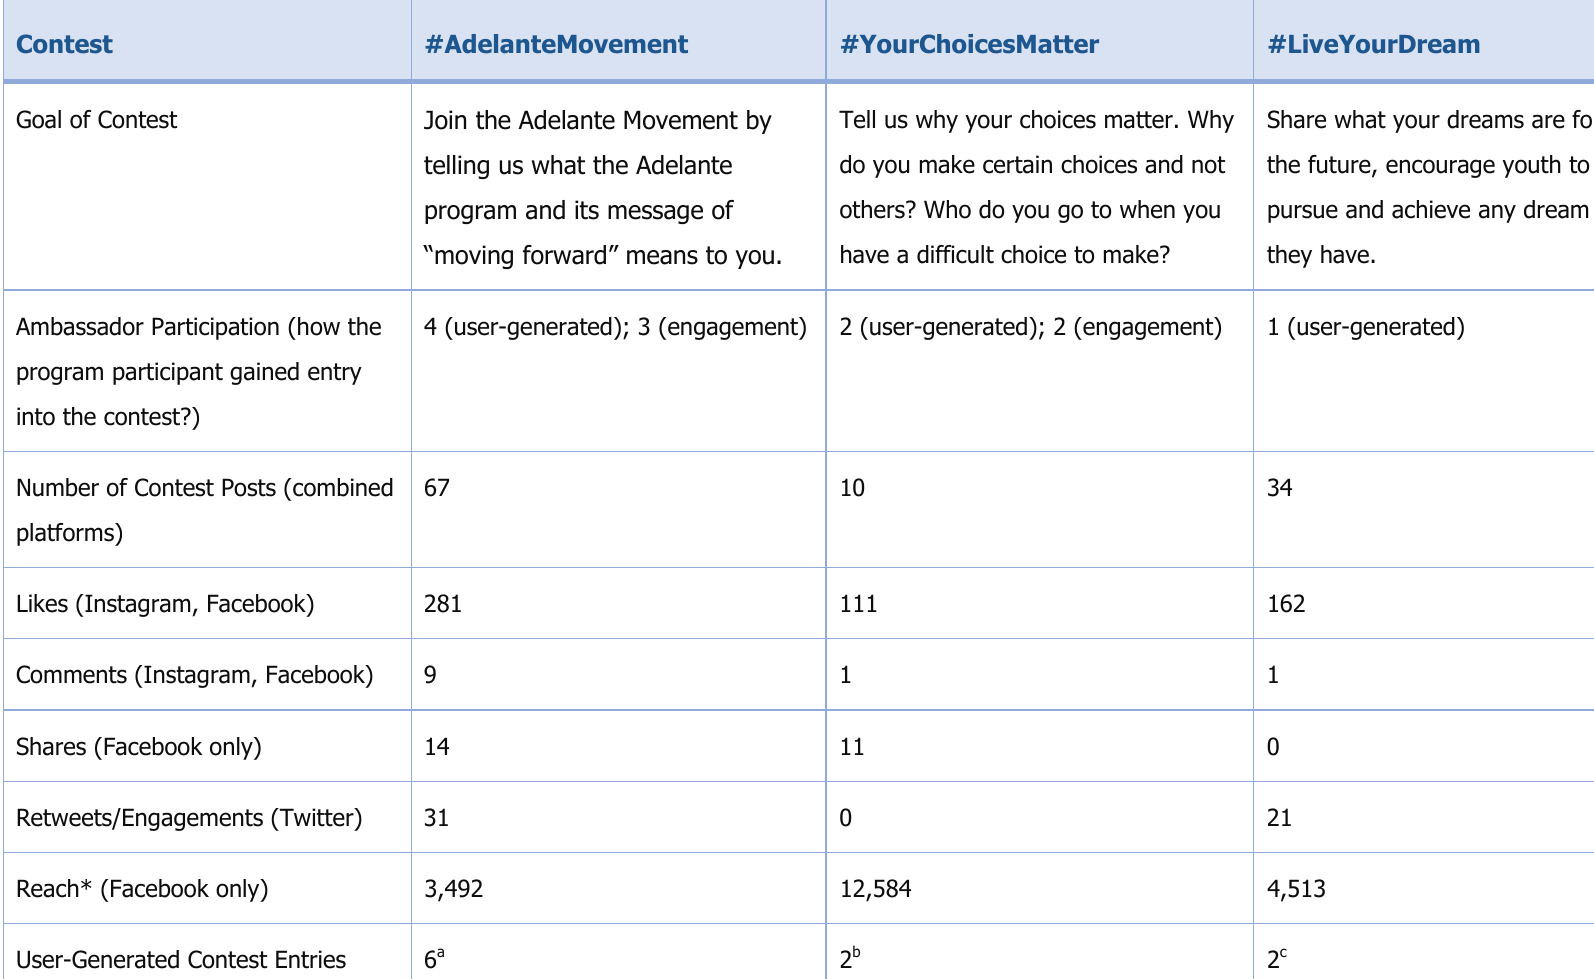
Table 4. Adelante Ambassadors Social Media Contest